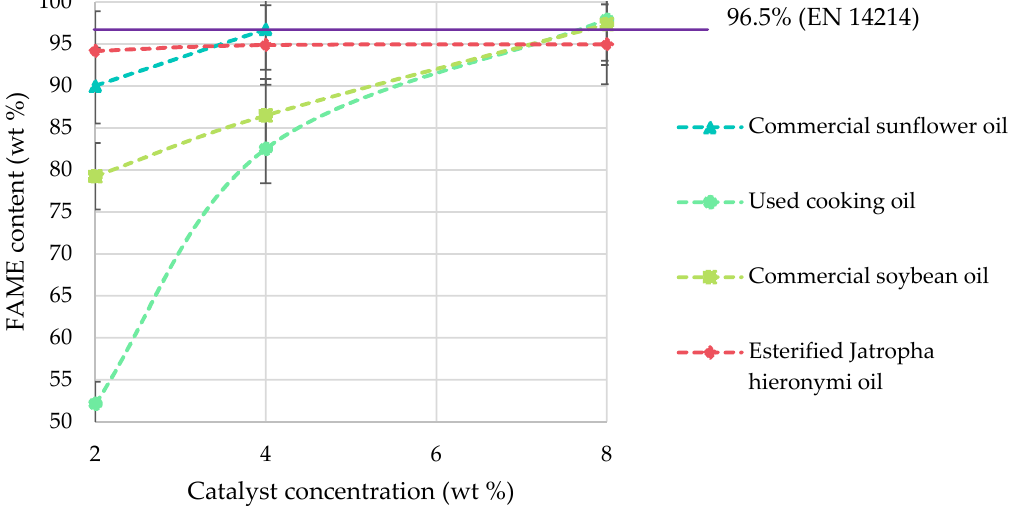
Figure 6. FAME contents obtained with different raw materials by employing alkali heterogeneous catalyzed transesterification at different catalyst loadings.